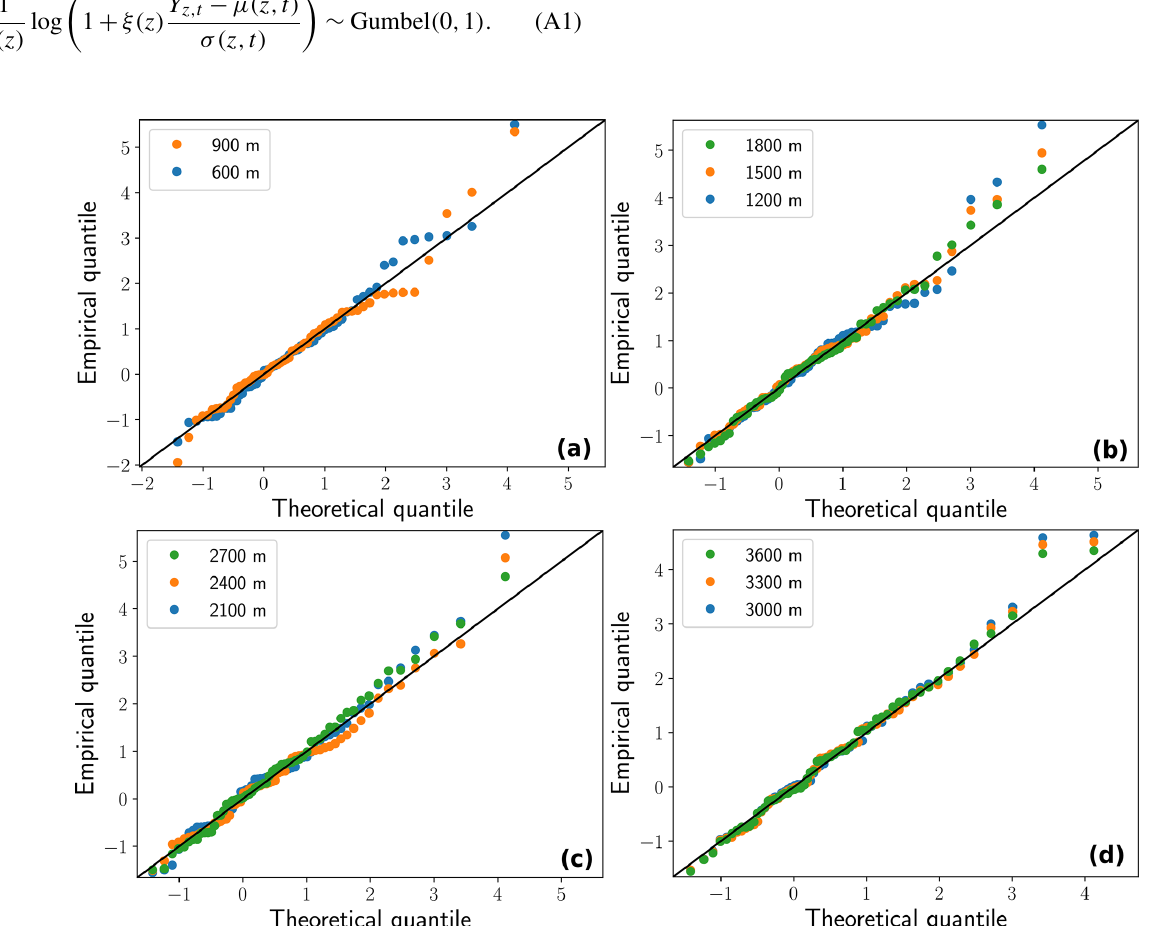
Figure A1. Q–Q plots of the selected elevational–temporal models for the Vanoise massif for the four ranges of elevations considered (see Fig. 1 for the time series). (a) Below 1000m. (b) Between 1000 and 2000m. (c) Between 2000 and 3000m. (d) Above